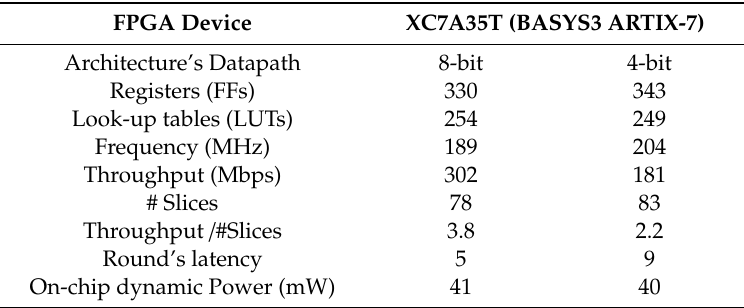
Table 2. Implementation